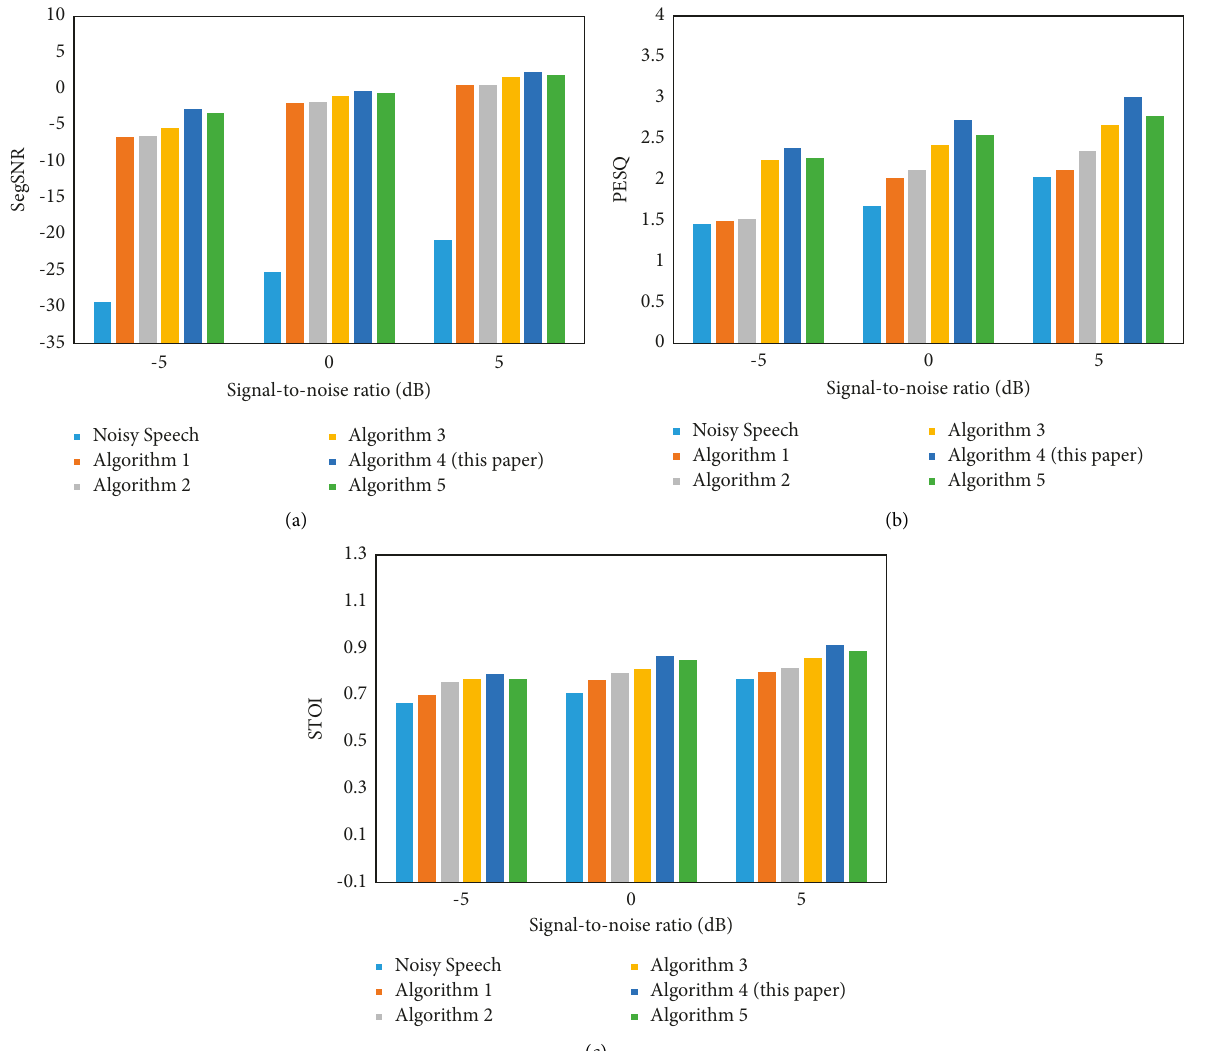
Figure 8: Comparison of three results of SegSNR, PESQ, and STOI under different algorithms in white-noise environment. (a) SegSNR; (b) PESQ; (c)